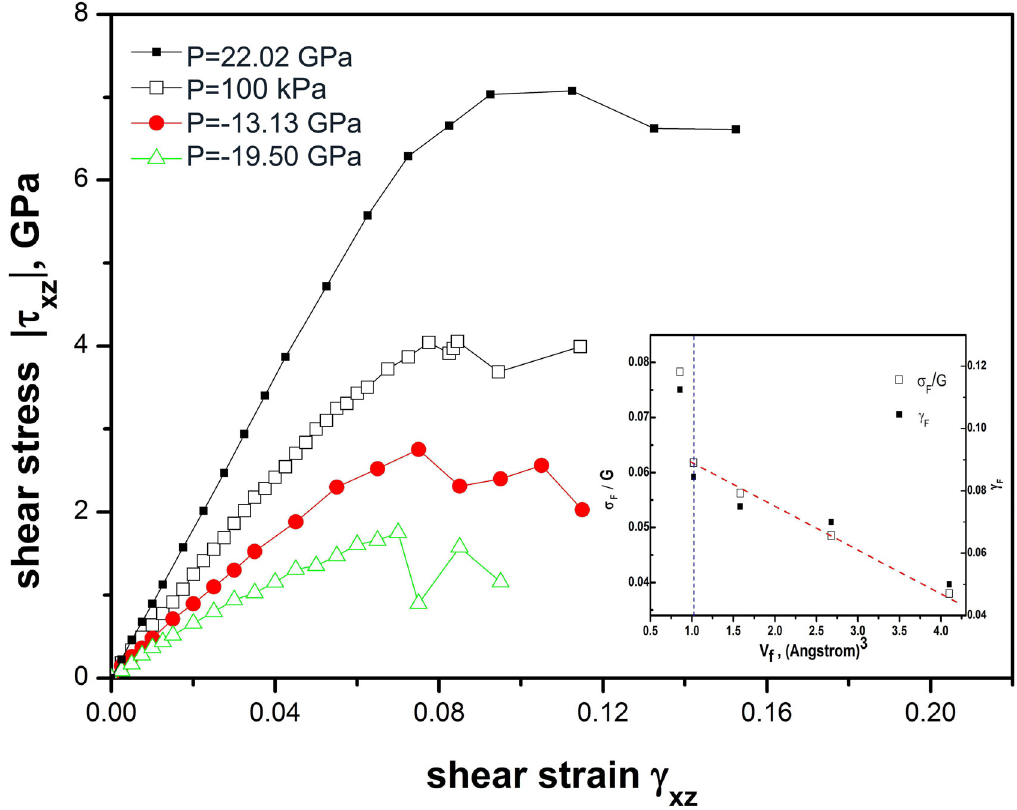
/ G and flow F of the glassy alloys. The blue dashed line f / G and  depend linearly on v F F f